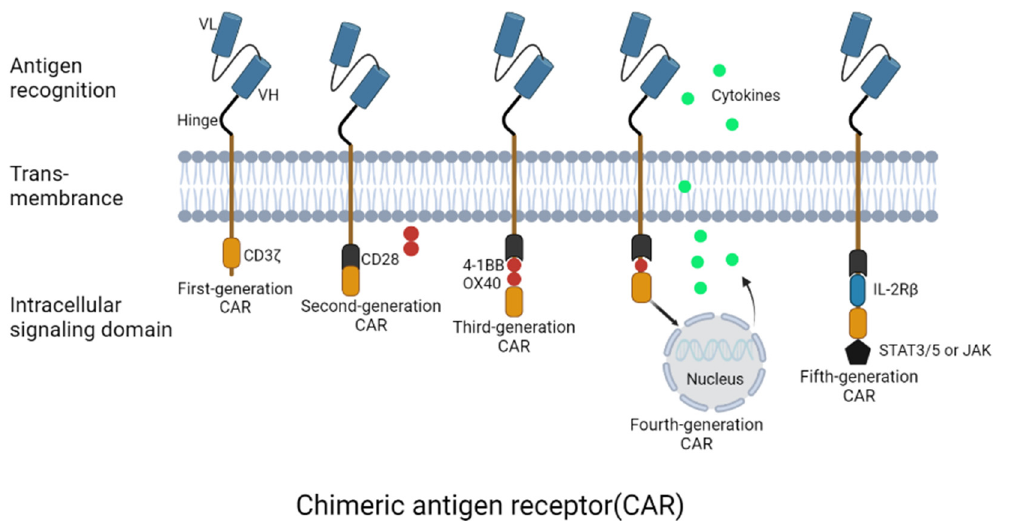
Figure 2. The design and evolution of different CAT-T cell generations. Three key structural domains are present in CAR-T cells: an external antigen-recognition domain, a transmembrane domain, and an intracellular signaling domain. In first-generation CARs, the T cell receptor’s (TCR) CD3 chain functions as an intracellular signaling domain alongside a transmembrane domain and an scFv targeting tumor-associated antigen (TAA) connected to a gap in an extracellular domain. By adding a co-stimulatory domain, such as CD28 or 4-1BB, the second-generation CARs increase the CAR-T cell activity. The third-generation CARs contain several co-stimulatory domains, such as OX-40 and 4-1BB. The fourth-generation CAR-T cells are designed to release engineered genes, such as cytokines, into tumor tissue when the CAR binds to a targeted antigen. The tumor immune microenvironment can be more e ff ectively overcome. The fi fth-generation CARs were designed to simultaneously activate the TCR, co-excitation domain CD28, and cytokine triple signaling, enhancing T cell proliferation, survival, and antitumor e ffi cacy.